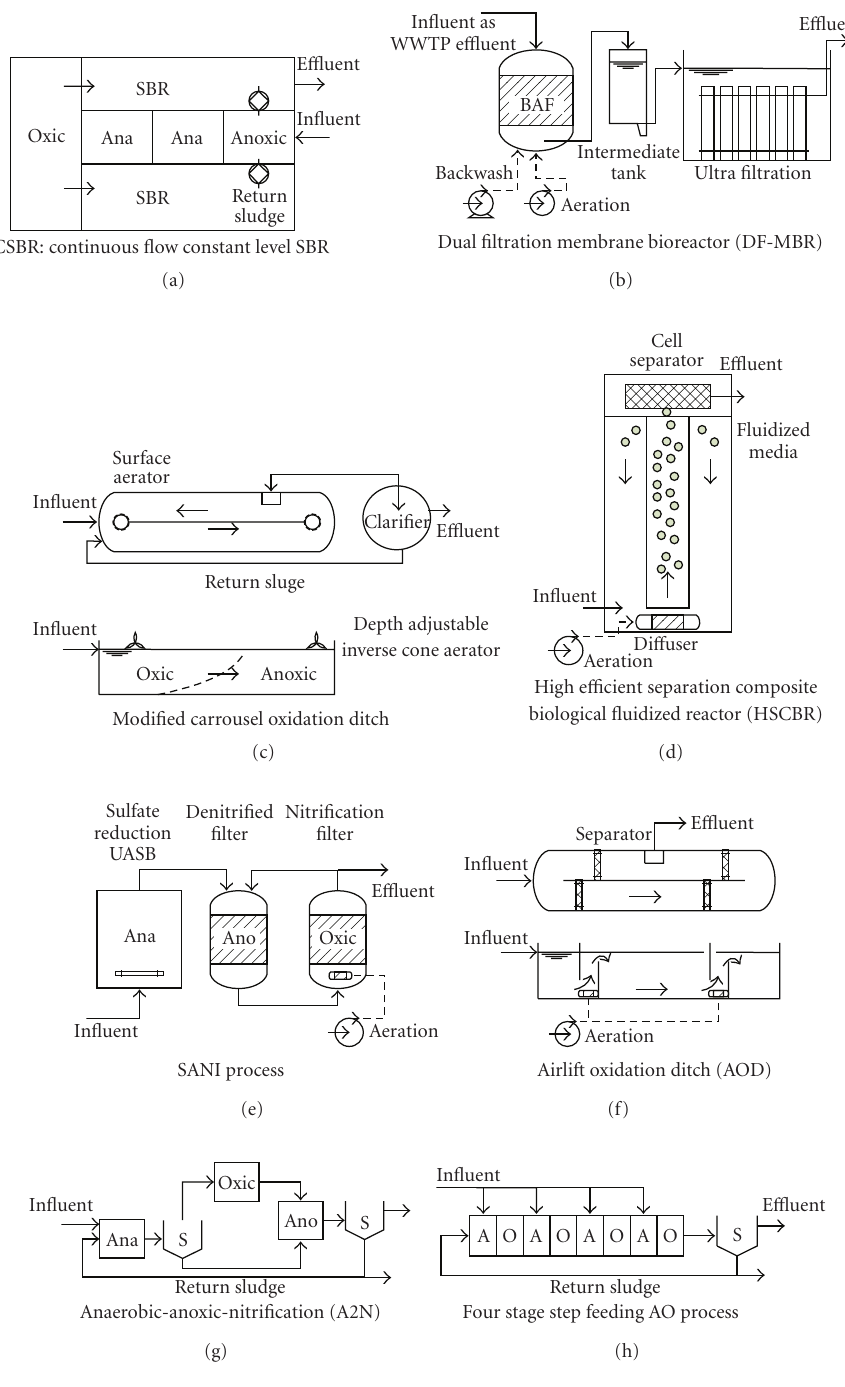
Figure 4: Innovated or modified processes in WWTPs in